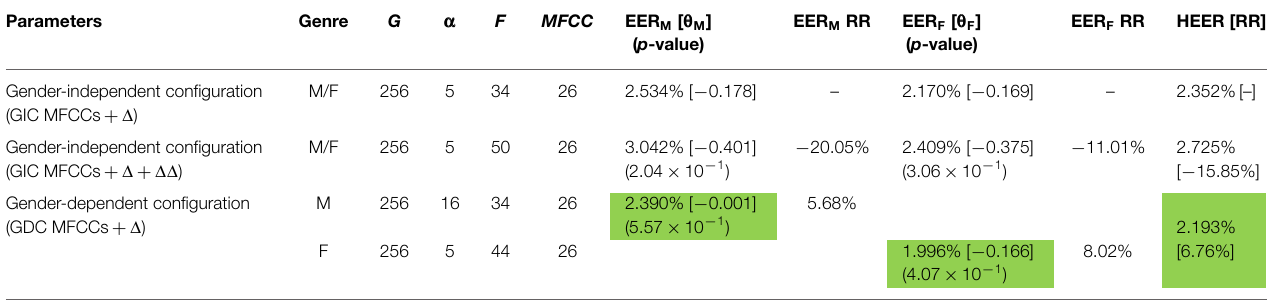
TABLE 2 | Configurations providing most successful results in terms of EER for GDC and GIC for the ALBAYZIN development set scenario [RR !!! Relative Reduction/[threshold]/( p -value)] .